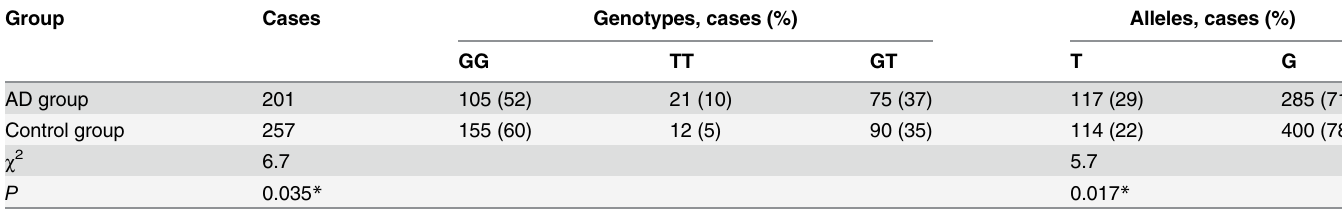
Table 5. Polymorphism distribution of rs1501299.